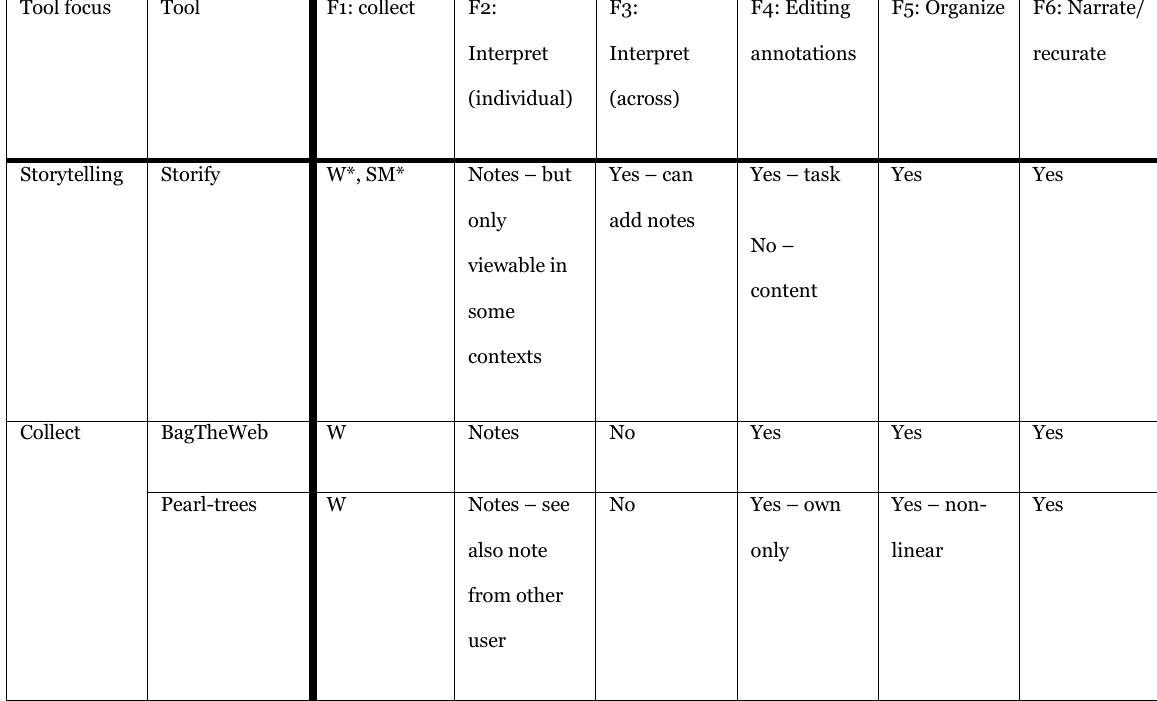
An Analysis of Digital Curation Tools (Wolff & Mulholland, 2013) Tool focus